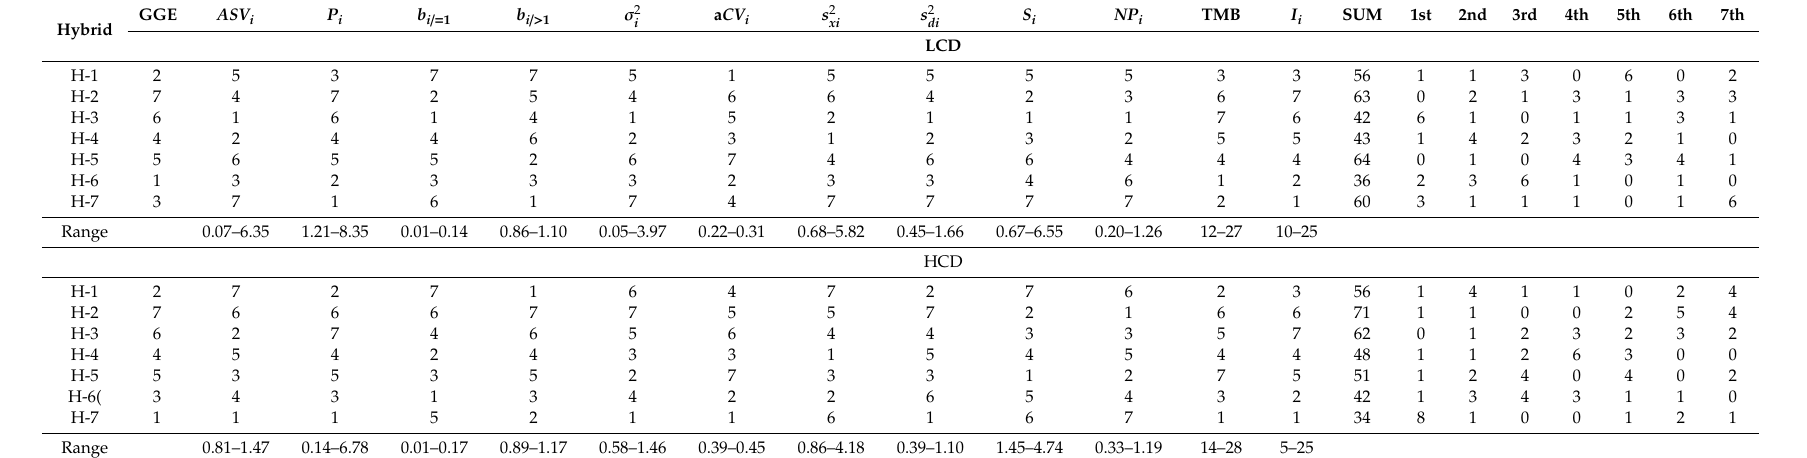
Table 2. Hybrid ranking according to statistics appraising stability, i.e., GGE biplot, parametric ( ASV i , P i , b i /= 1 , b i /> 1 , σ 2 ( S i , NP i , TMB, I i ), as well as the sum of ranking, at the low crop density (LCD), and the high crop density (HCD). At the bottom of each density-group, the range of absolute values is also given. On the right part it is shown the number of times each hybrid was 1st, 2nd,